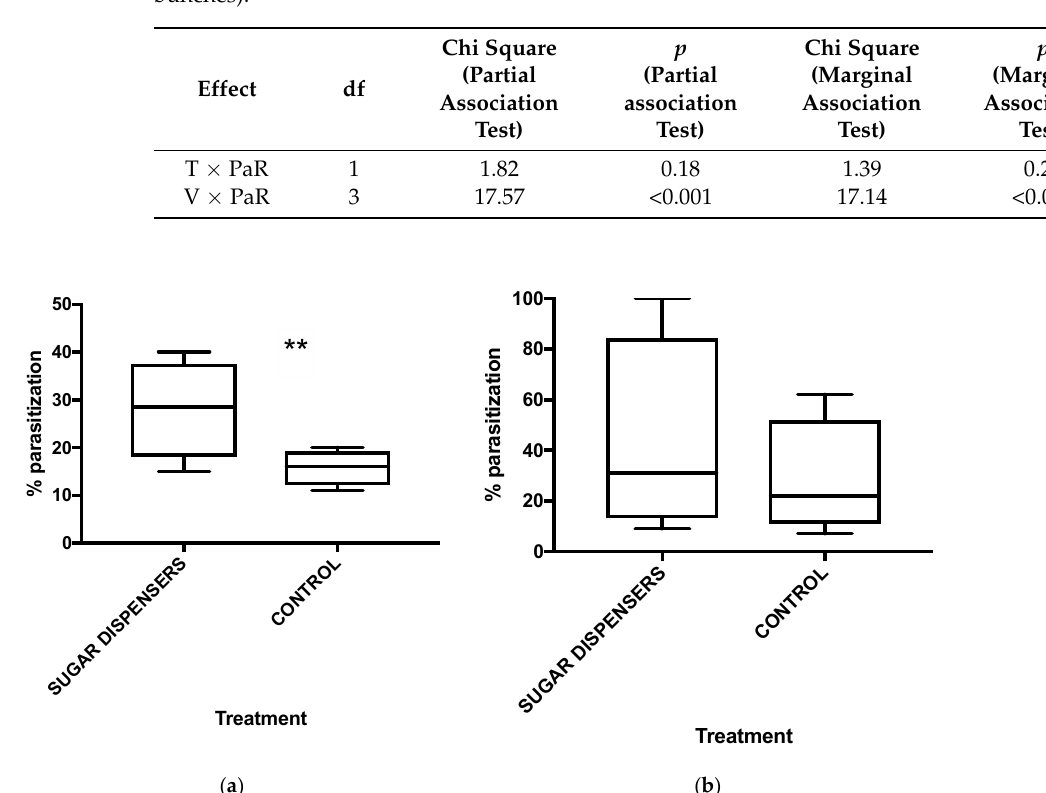
Figure 7. Mean percentages of parasitization ( n = 4) on colonies ( a ) and randomly-collected bunches ( b ). Box plots indicate the median (solid line) and the range of dispersion (the lower and upper quartiles); the whiskers (vertical lines) represent the minimum and maximum parasitization rates observed. Log linear analysis detected a significant difference of parasitization rate between the two treatments on colonies (** = p < 0.01) ( a ), whereas no significant difference of parasitization rate was observed between sugar dispenser and control plots on randomly-collected bunches ( p > 0.05) ( b ) .